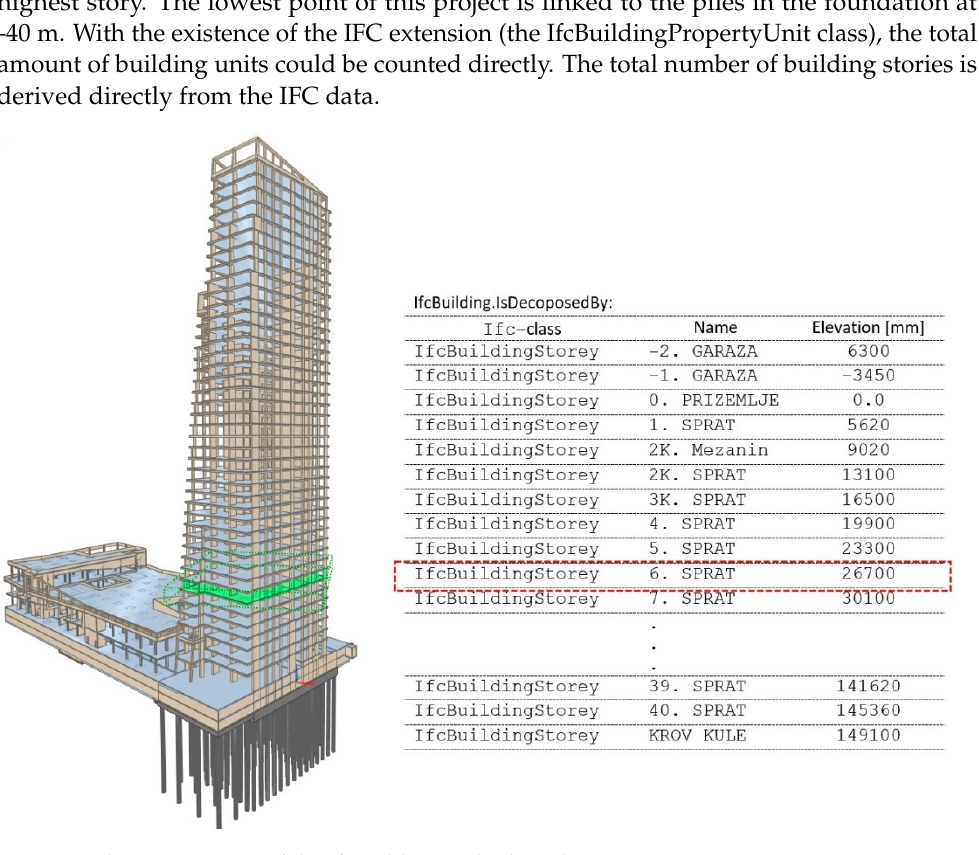
Figure 7. The containment of the IfcBuilding and selected story.